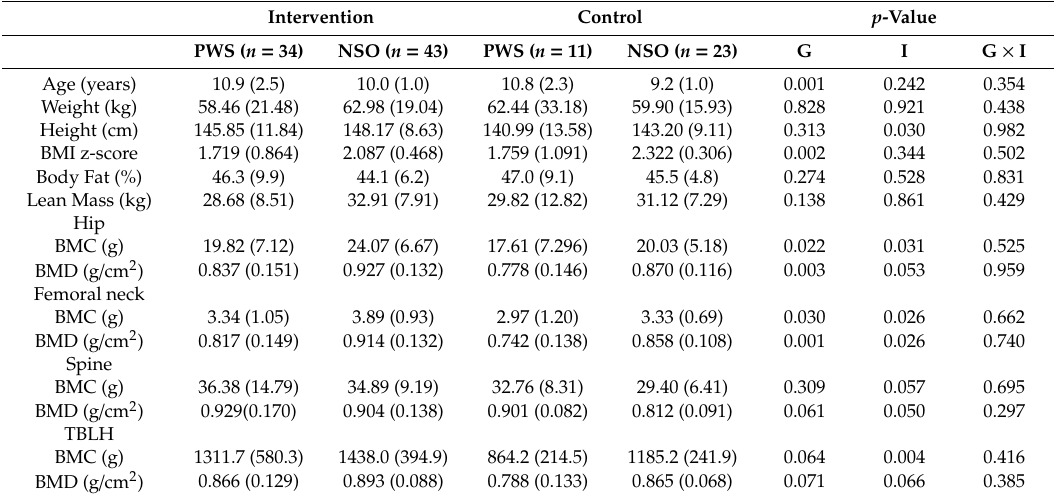
Data are presented as mean (standard error of the mean). Abbreviations: BMC = bone mineral content, BMD = bone mineral density, TBLH = total body less head, G = group (PWS vs. NSO), I = intervention treatment allocation (intervention vs. waitlist control), G × I = group by intervention